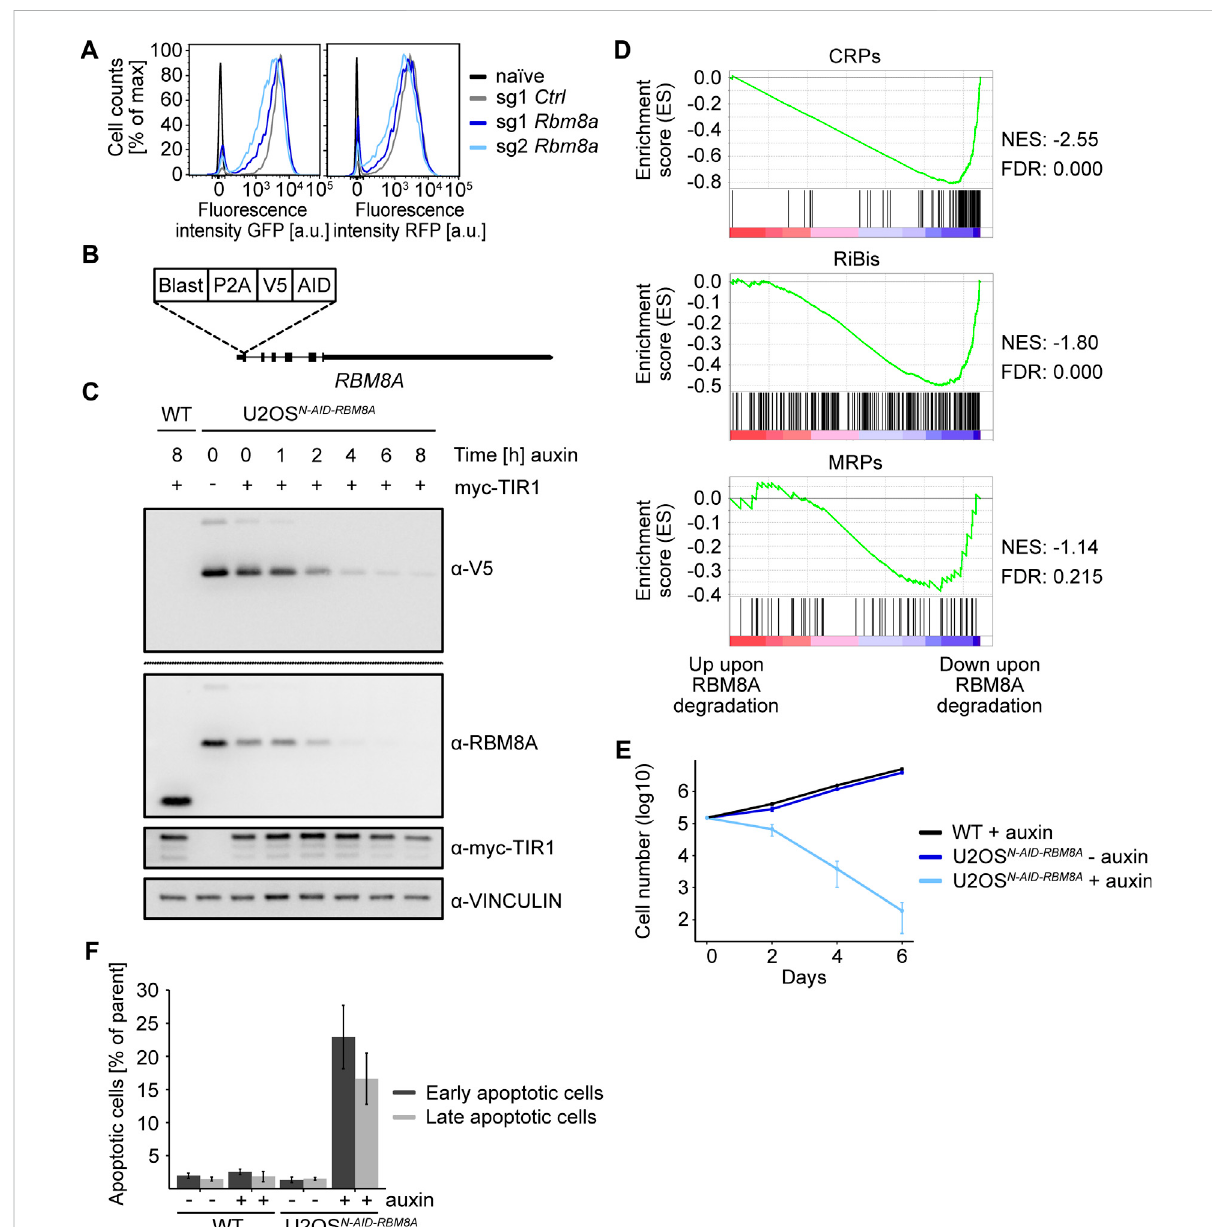
FIGURE 5 Analysis of the role of RBM8A in ribosome biogenesis. (A) FACS analysis of Fbl -promoter-driven EGFP-PEST (GFP) and Rpl18 -promoter-driven tRFP-PEST(RFP)upon Rbm8a knockout.FACSanalysisoftwodifferentsgRNAstargetingRbm8asixdaysafterlentiviralinfectionandselectionofthe screening cell line 3T3 Fbl − GFP;Rpl18 − RFP . sg1 Ctrl = non-targeting, naïve = wild type NIH/3T3 cells. Representative experiment from a quadruplicate experiment. (B) Scheme ofthehomozygous N-AID-RBM8A knock-in. Blast= Blasticidin, P2A =porcine teschovirus-1 2Aself-cleaving peptide, V5 = V5-tag, AID = auxin-inducible degron tag. (C) Western blot of N-AID-RBM8A upon addition of auxin for different time periods. The U2OS N − AID- RBM8A cell clone was infected with virus encoding the F-box transport inhibitor response 1 (TIR1) protein and treated with 500 µM auxin for different time periods. The V5-blot was a whole membrane blot. Single experiment. WT = wild type U2OS cells. (D) Gene set enrichment analysis (GSEA) of ribosome biogenesis genes and ribosomal protein genes upon acute (6 h) RBM8A depletion and nascent RNA sequencing (4sU-Seq). Genes were ranked by log10 ( p -value) with the sign indicating the direction of the fold change in the exon-excluding 4sU-Seq data (a negative fold change indicates downregulation upon RBM8A knockdown compared to the cell line without auxin treatment). The gene sets analyzed were downloaded from the MSigDB database: “ GOBP_RIBOSOME_BIOGENESIS.v7.5.1 ” , “ GOCC_ORGANELLAR_RIBOSOME.v7.5.1 ” , and “ GOCC_CYTOSOLIC_RIBOSOME.v7.5.1 ” . RiBis = ribosome biogenesis genes, MRPs = mitochondrial ribosomal protein genes, CRPs = cytosolic ribosomal protein genes, NES = normalized enrichment score, FDR = false discovery rate. (E) Logarithmic (log10) growth curve of wild type (WT) TIR1-expressing U2OS cells treated with auxin and the U2OS N − AID-RBM8A cell clone ± auxin in triplicates. Error bars represent standard deviation of triplicates. (F) Annexin V/PI-FACS of WT TIR1-expressing U2OS cells and the U2OS N − AID-RBM8A cell clone±auxin in triplicates. 48 h auxin treatment. Early apoptotic cells are cells with high Annexin V, but low propidium iodide (PI) signal. Late apoptotic cells are cells with high Annexin V and high propidium iodide (PI) signal. Error bars represent standard deviation of